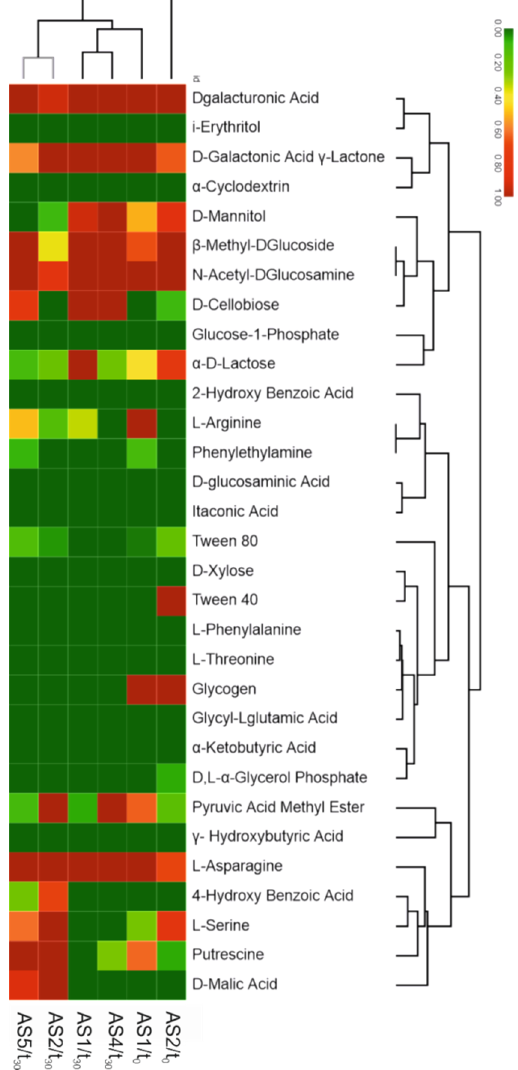
Figure 6. Cluster analysis based on the Spearman’s rank correlation coefficients estimated for the Biolog ® EcoPlates TM carbon sources utilization patterns for the different experimental conditions (assays AS1, AS2, AS4, and AS5) during the experimental period (30 days). All data were normalized and presented as a color scale ranging from green (MIN, means 0) to red (MAX, means 1).